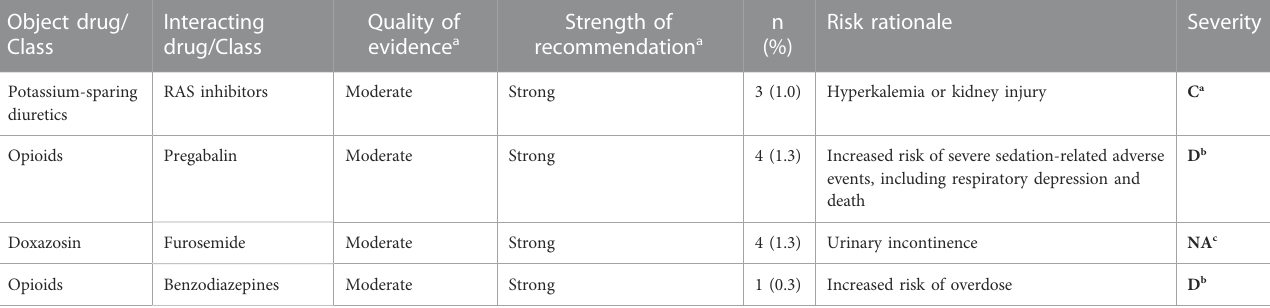
TABLE 4 Potentially clinical important drug-drug interactions to be avoided using the 2019 Beers Criteria. Object drug/